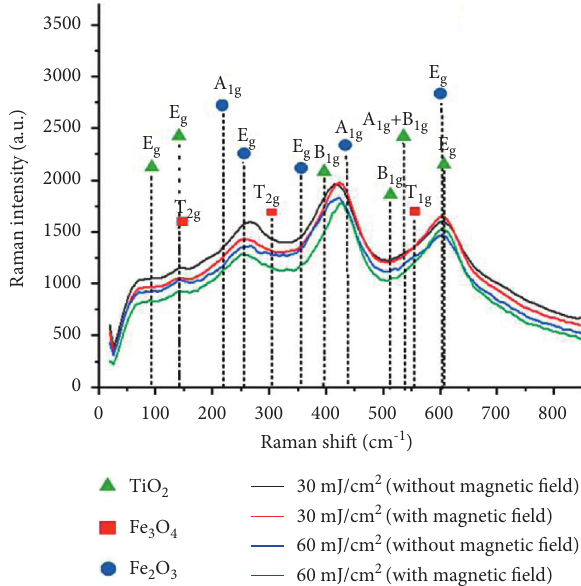
Figure 9: Raman spectra of the major constituent NPs.